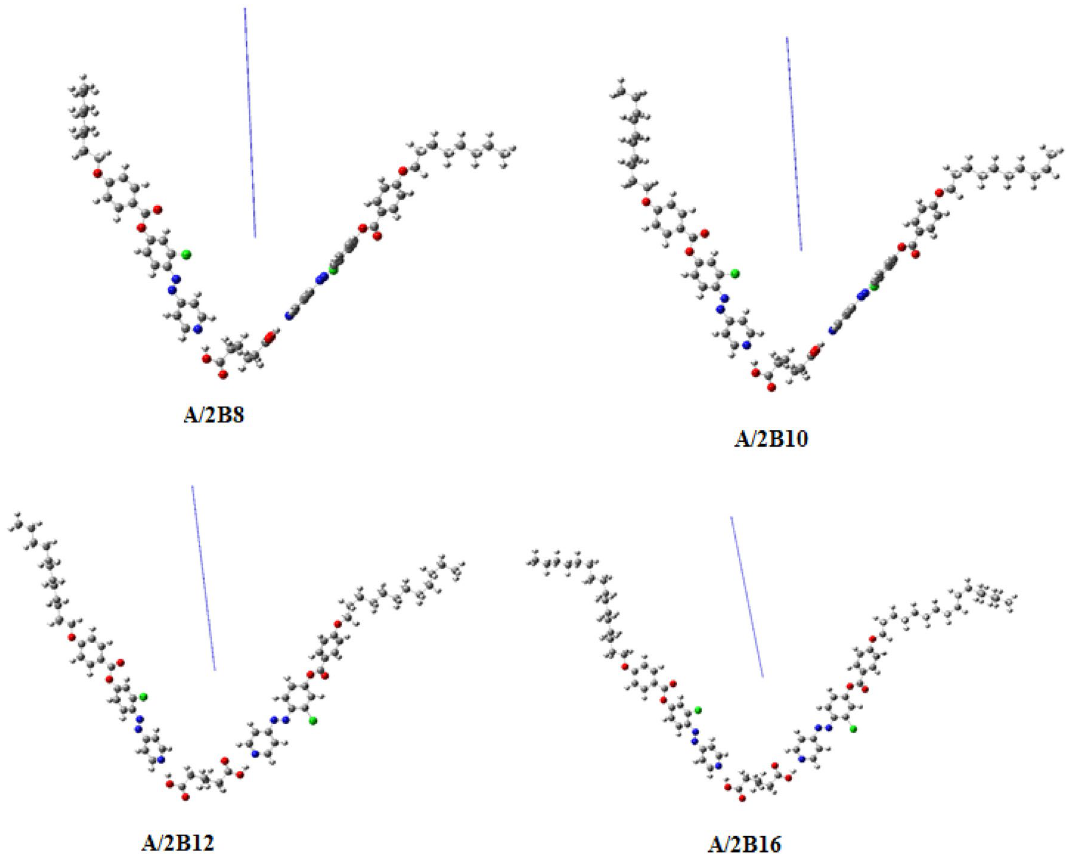
Figure 7. Atomic charges and dipole moment vector for the optimized structures of prepared complexes A/2Bn, calculated at B3LYP/6-31 g(d,p) level.